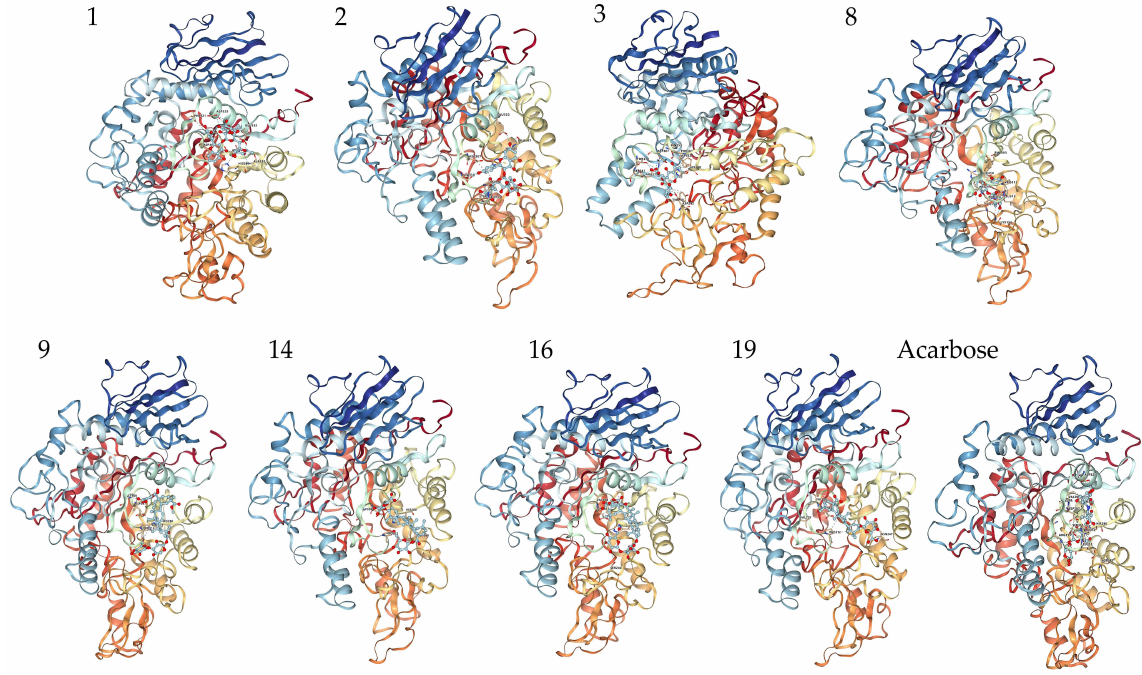
Figure 6. Molecular docking analysis and 3D modeling for the interaction between the compounds (Table 5) and α -glucosidase. Compounds 1 , 2 , 3 , 8 are flavonoids; Compounds 9 , 14 , 16 , 19 are triterpenoid saponins.